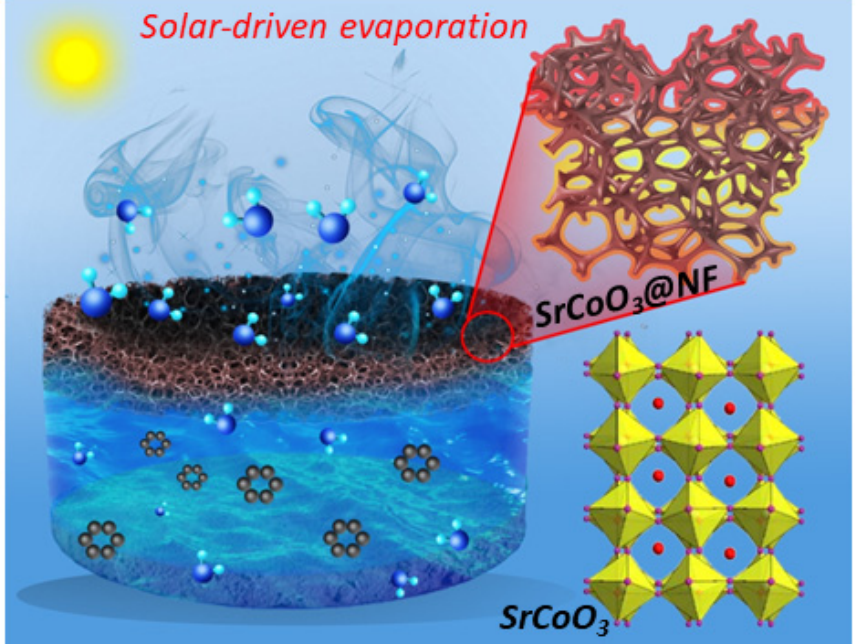
Figure 1. Schematic illustration of strontium-cobaltite-based perovskite (SrCoO 3 ) for solar-driven interfacial evaporation systems for clean water generation.